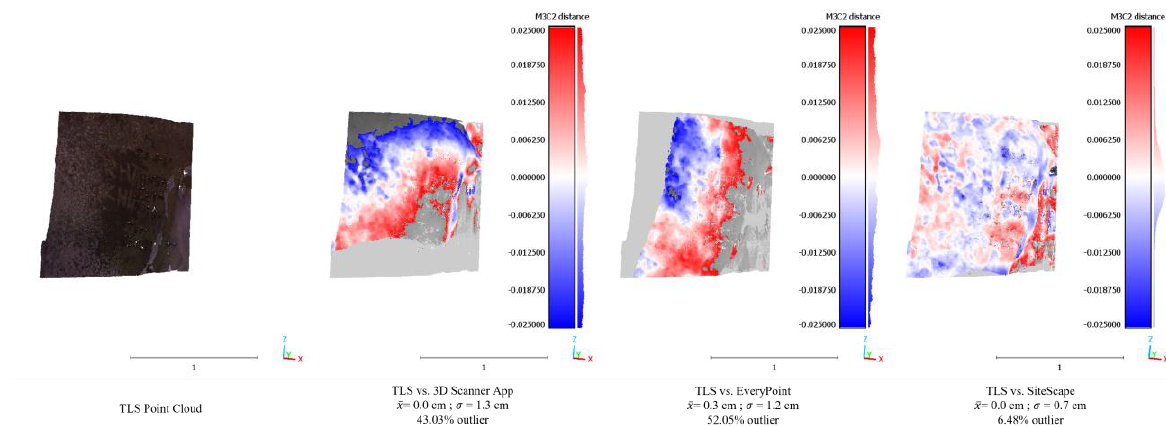
Figure 4. The comparison in case (2) is between TLS and iPad LiDAR using M3C2 analysis in Cloud Compare. The gray area represents an outlier.